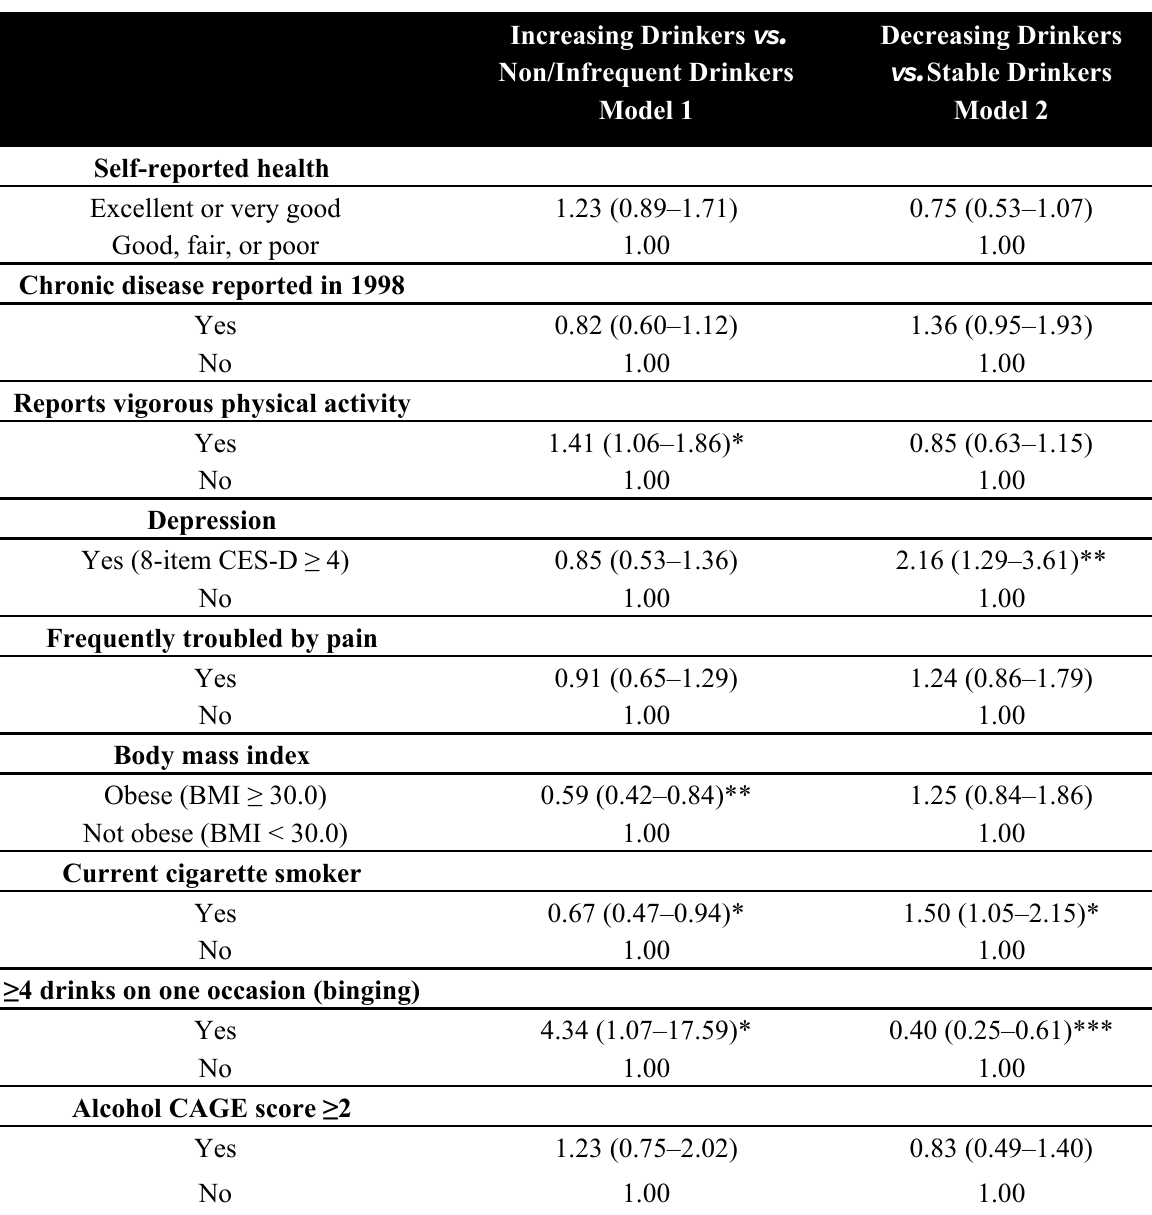
Increasing Drinkers